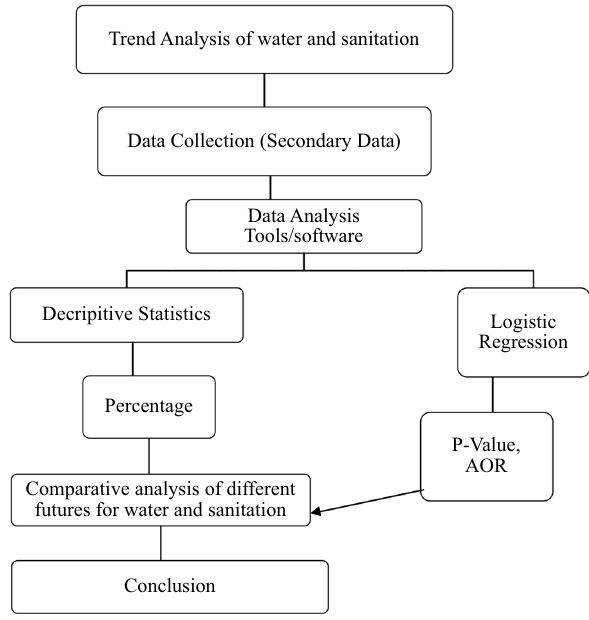
Fig. 1 General methodologi- cal framework Trend Analysis of water and